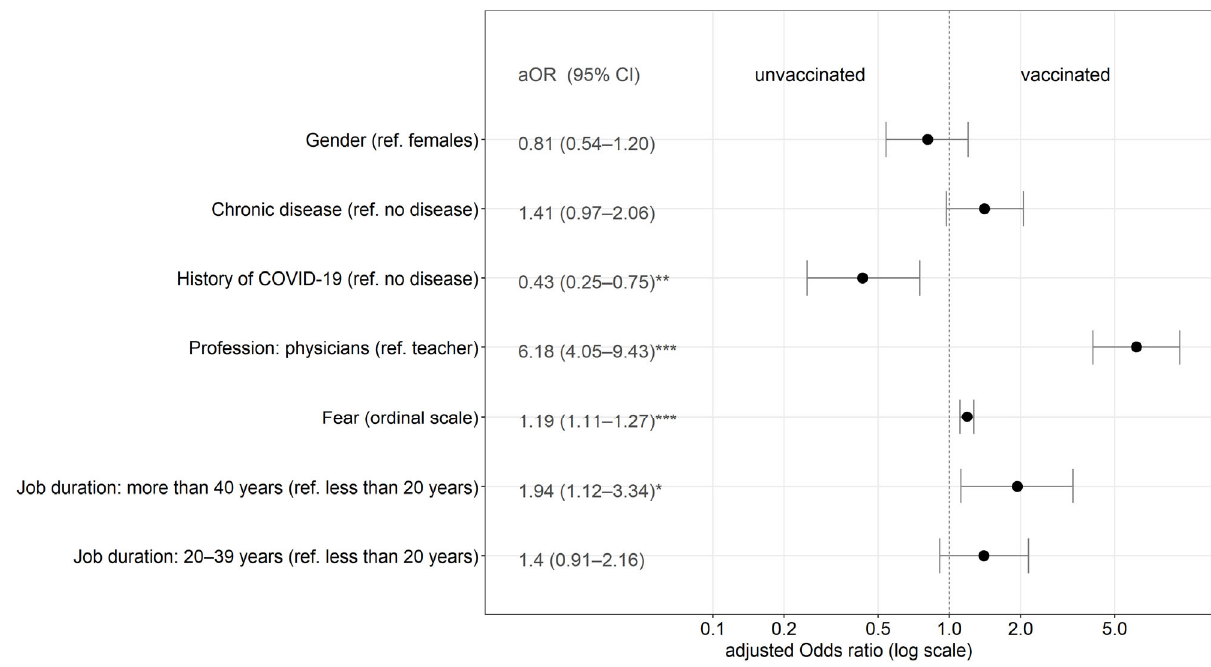
Figure 1. Predictors of simultaneous vaccination against COVID ‐ 19 and seasonal influenza (last season) (multivariate logistic regression analysis). Note: * p < 0.05; ** p < 0.01; *** p < 0.001.